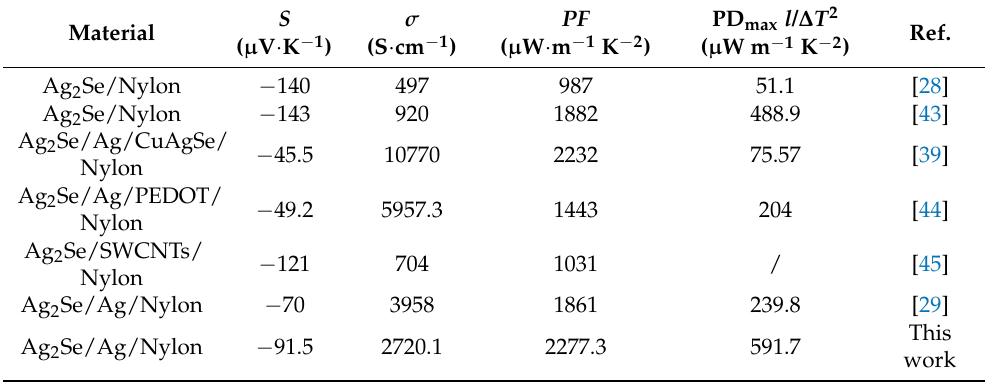
Table 1. Comparison of TE performance of Ag 2 Se/nylon-based films at room